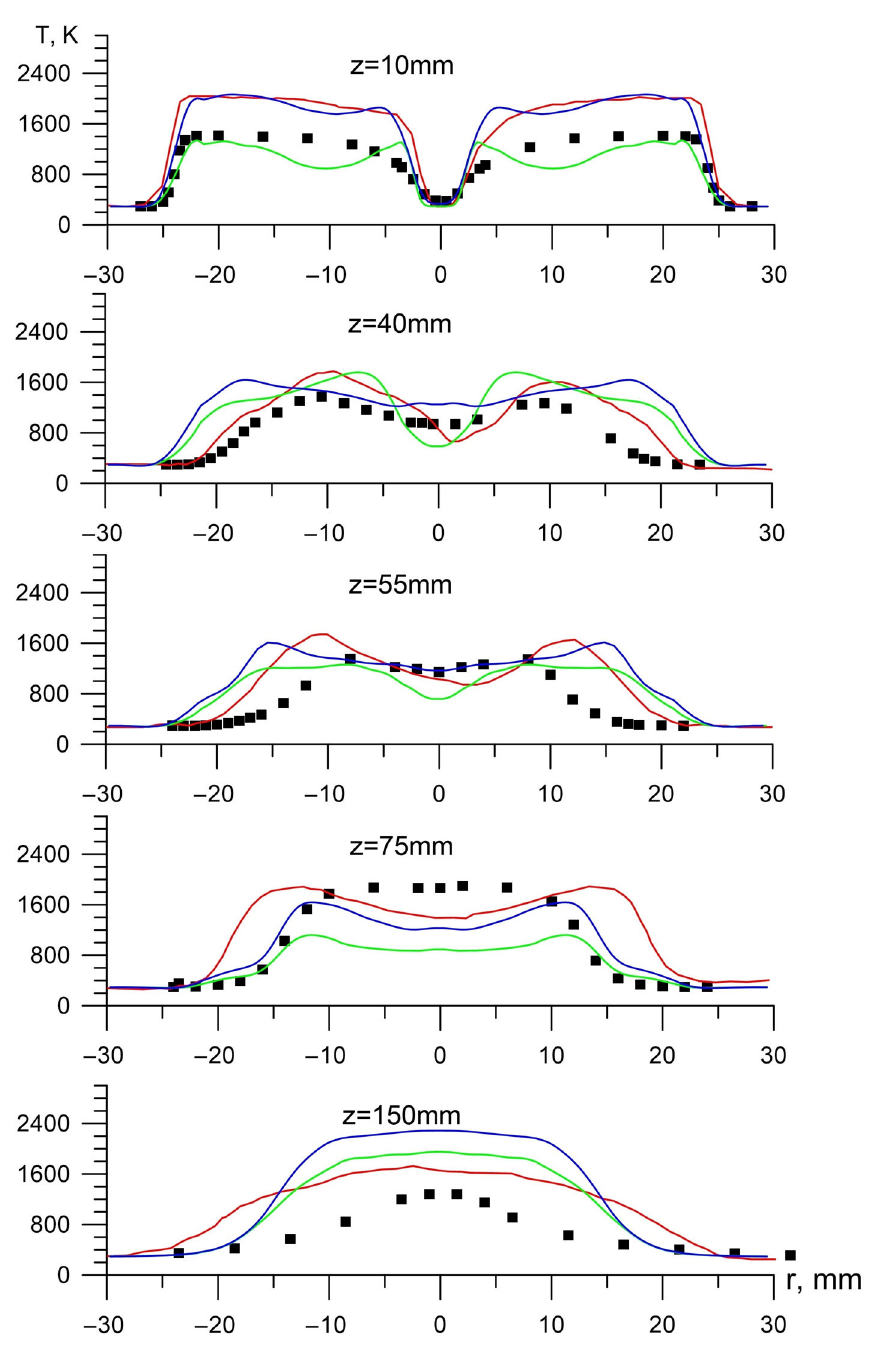
Figure 10. Comparison of the average temperature profiles. Designations as in Figure 6.